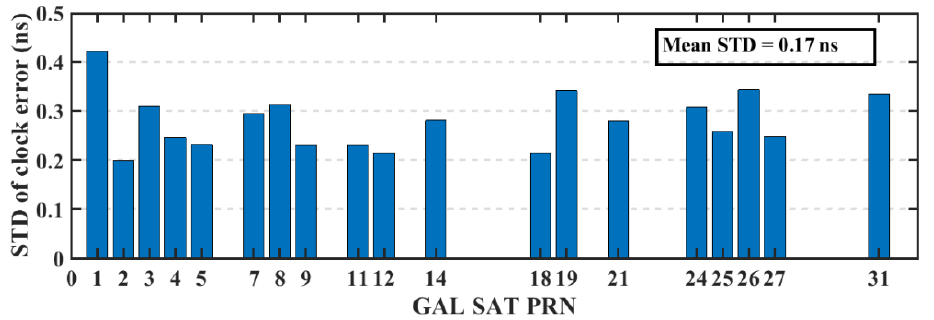
Figure 5. STD of GPS satellites’ clocks based on NAVCAST real-time products.